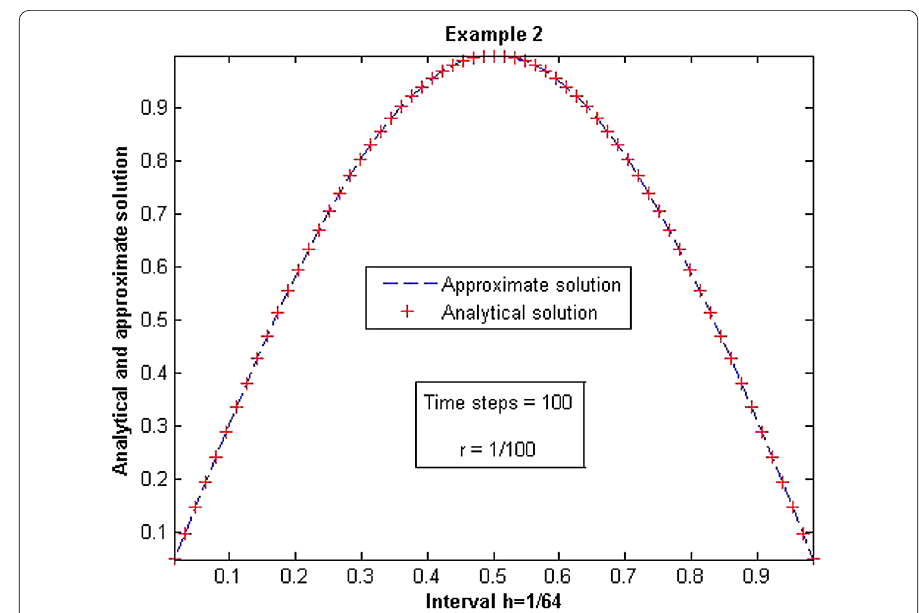
Figure 2 Comparison between analytical and approximate solution